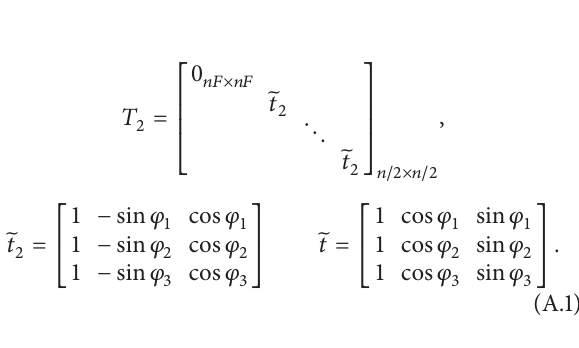
Figure 11: Comparison of tower base yaw